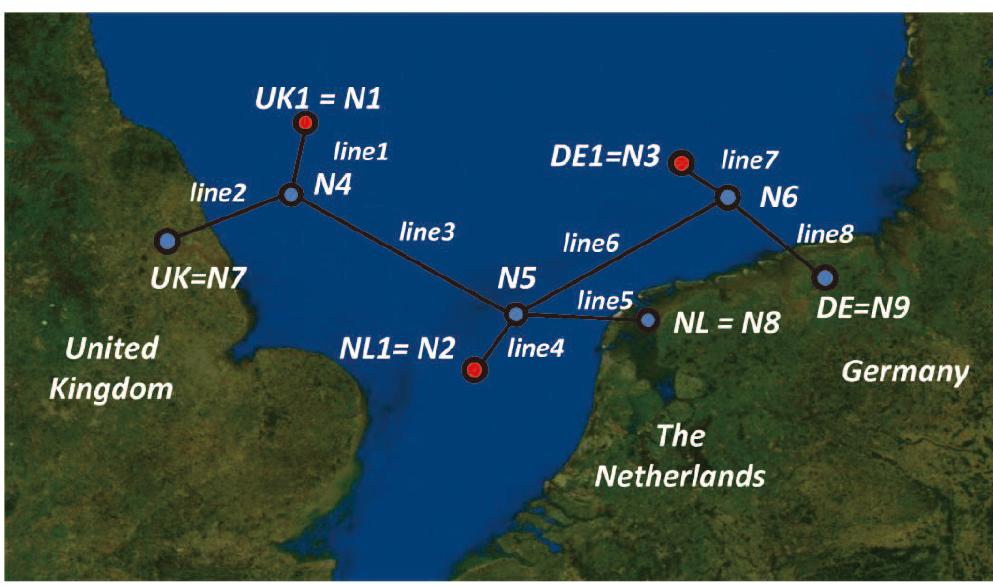
Figure 1. Topology of the modeled MTDC grid.